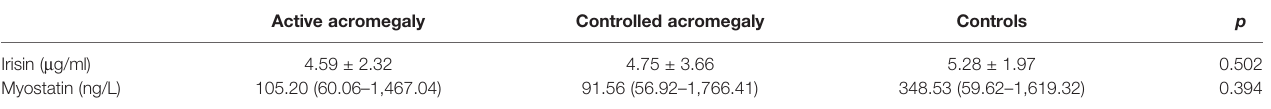
TABLE 3 | Circulating myokine concentrations in patients with active acromegaly, controlled acromegaly, and